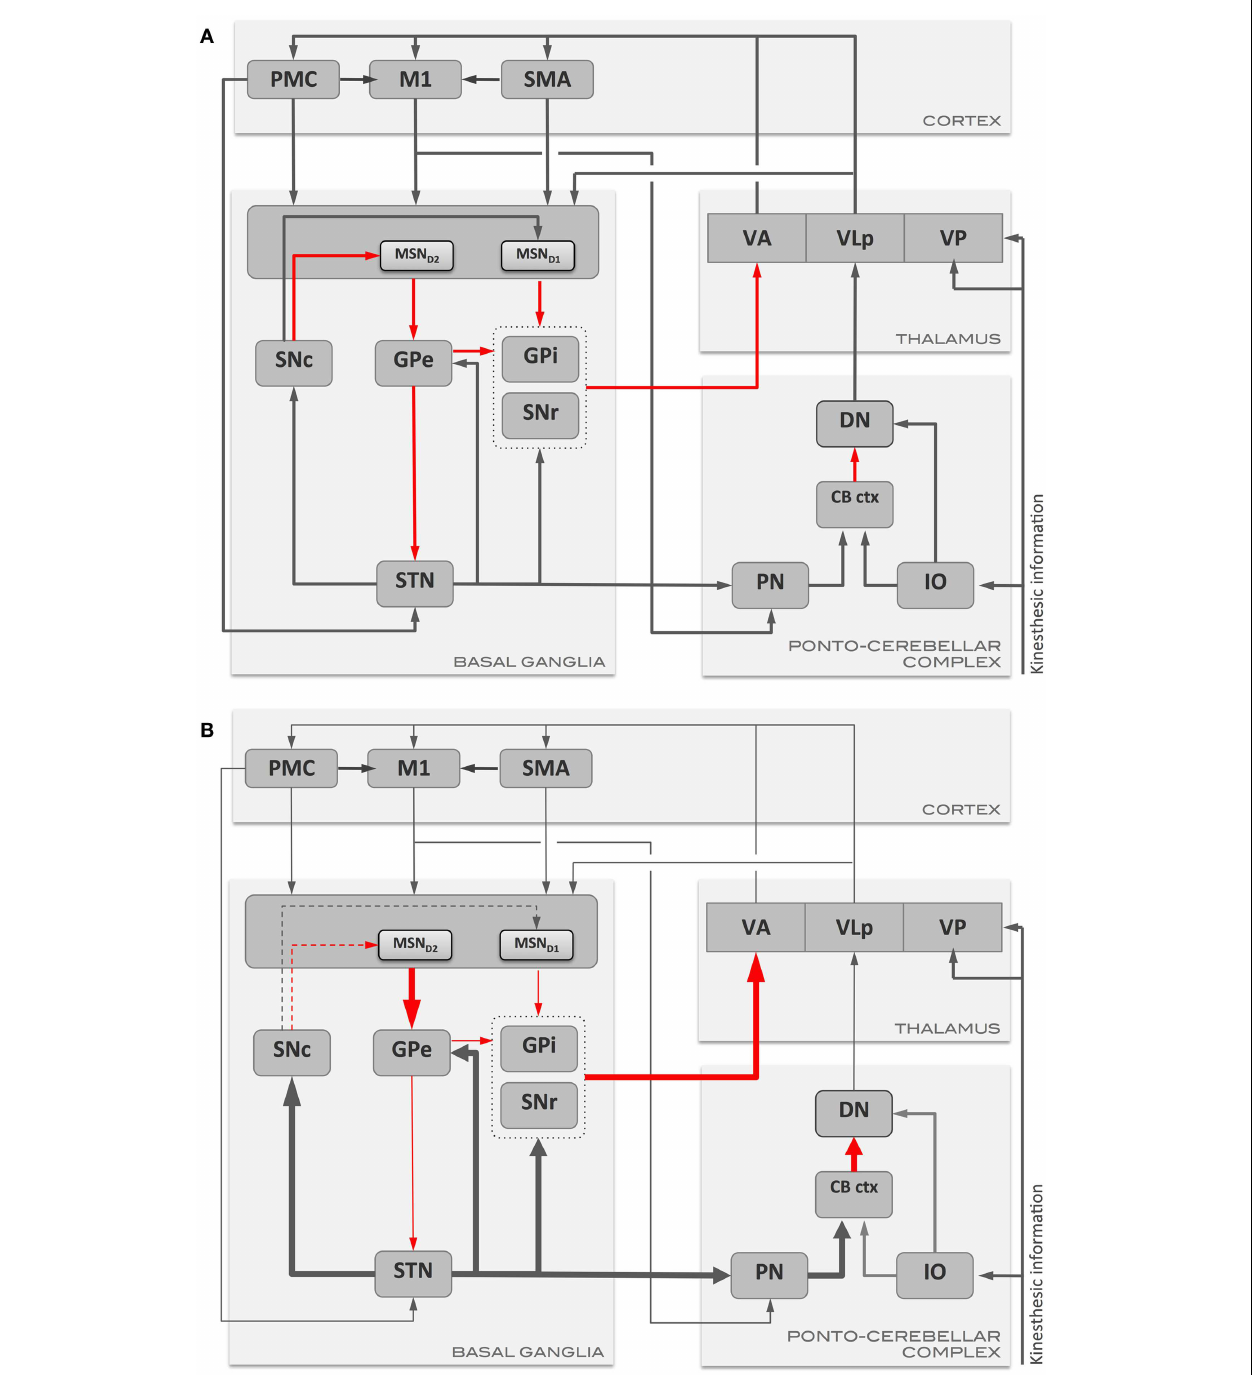
globus pallidus externus; GPi, globus pallidus internus; IO, inferior olive; M1, primary motor cortex; MSN, medium spiny neurons (MSN D1/D2 : MSN with D1 or D2 dopamine receptors); PMC, pre-motor cortex; PN, pontine nuclei; SMA, supplementary motor area; SNc, substantia nigra pars compacta; SNr, substantia nigra pars reticulata; STN, subthalamic nucleus;VA, ventro-anterior thalamic nucleus;VLp, ventro-lateral thalamic nucleus, pars posteriori;VP, ventro-posterior thalamic